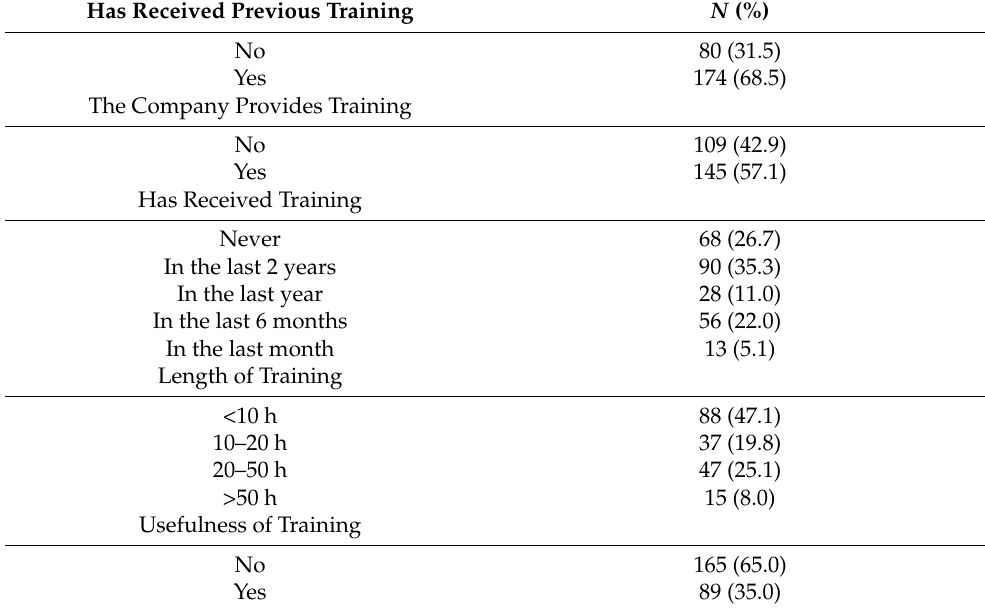
Table 2. Training received by